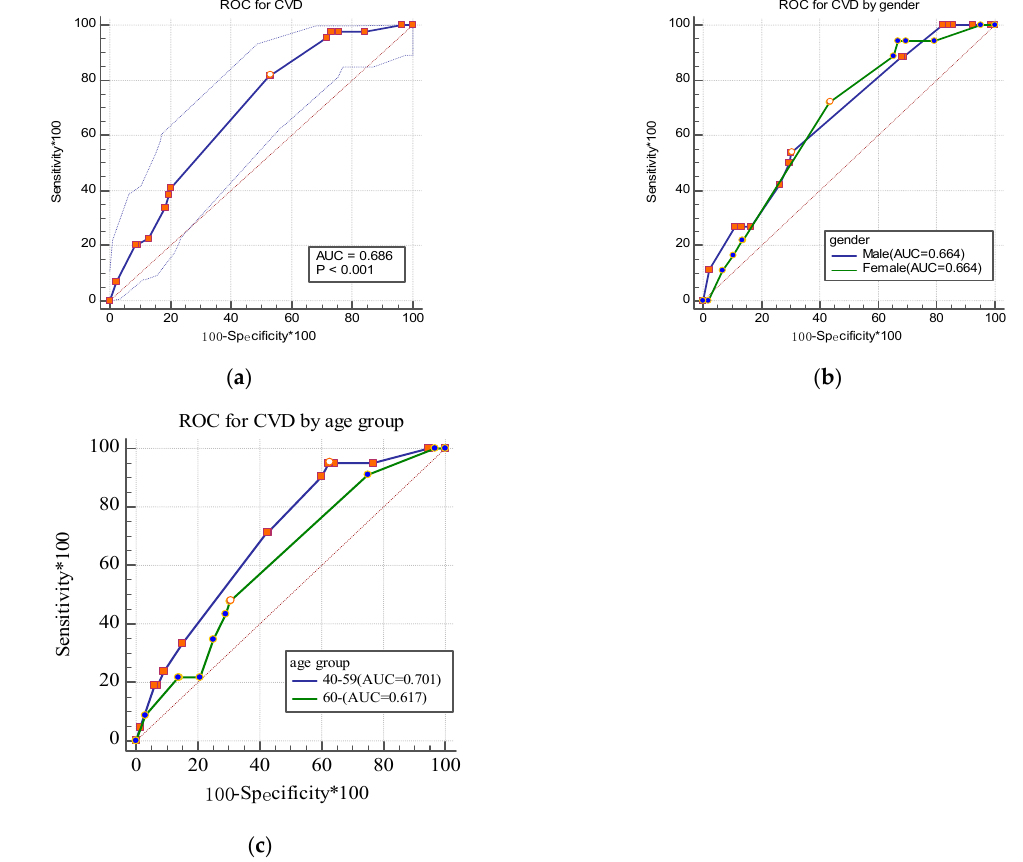
Figure 1. Receiver operating characteristic (ROC) curve for identifying cerebrovascular disease by gender ( a , b ) and age group ( c ) in the study.